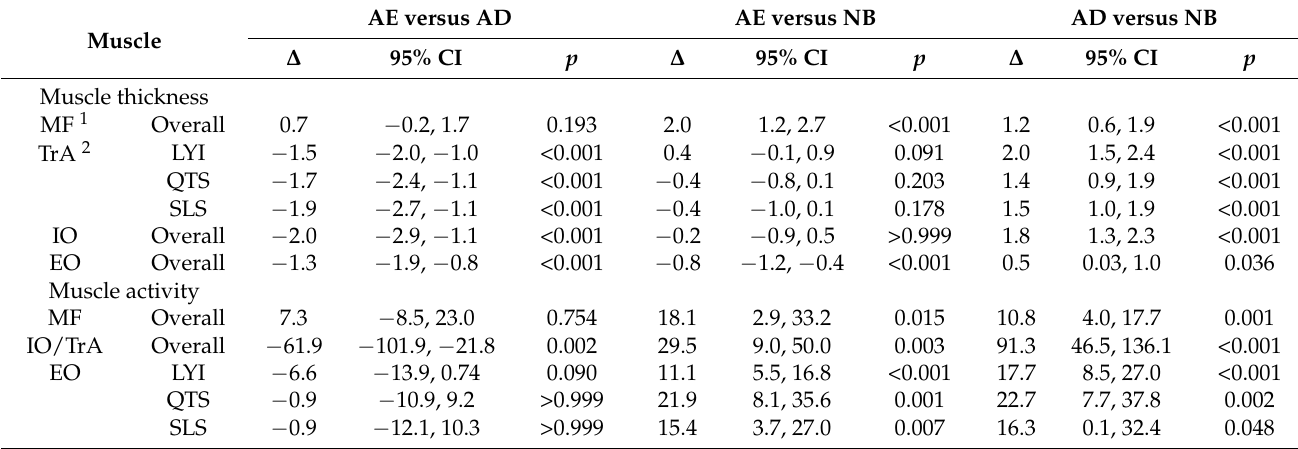
Table 3. Comparisons for the thickness and activity of the lumbar multifidus and lateral abdominal wall muscles between different volitional preemptive abdominal contraction (VPAC)